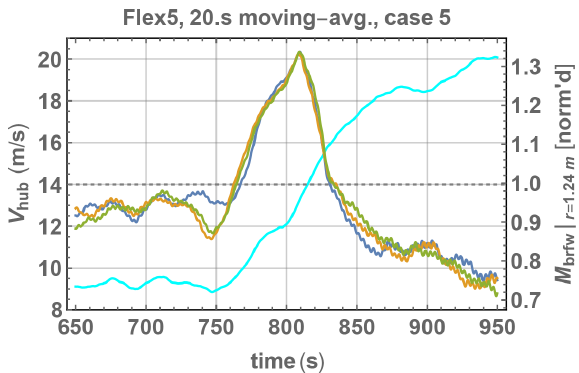
Figure 21. Stand-alone CMM/Flex5 simulation for case 5: hub-height wind speed (cyan), along with blade-root flap- wise bending moment [ M brfw ] near base ( r = 1 . 24m) for each blade (blue/gold/green); loads are normalized by respective pre- ramp mean